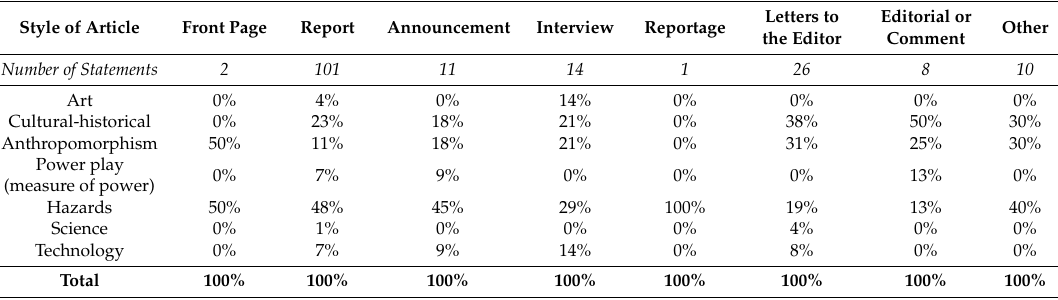
Table A1. Number of statements for the different article styles and framing of the statements, shown as a percentage for each